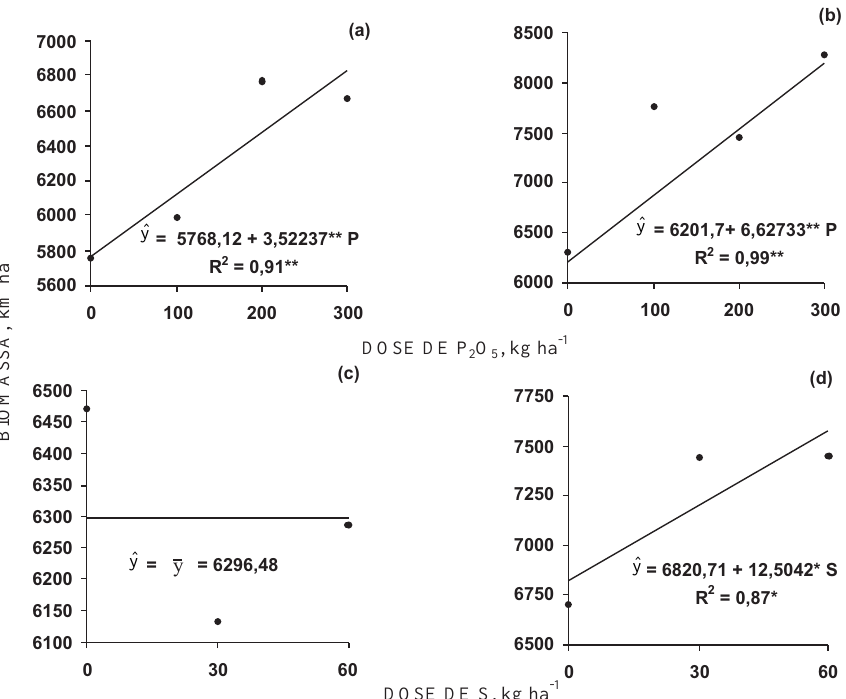
Figura 1. Produção de biomassa seca da aveia, de acordo com as doses de fosfato natural reativo (a), de superfosfato triplo (b) e doses de enxofre para as fontes fosfato natural reativo (c) e superfosfato triplo